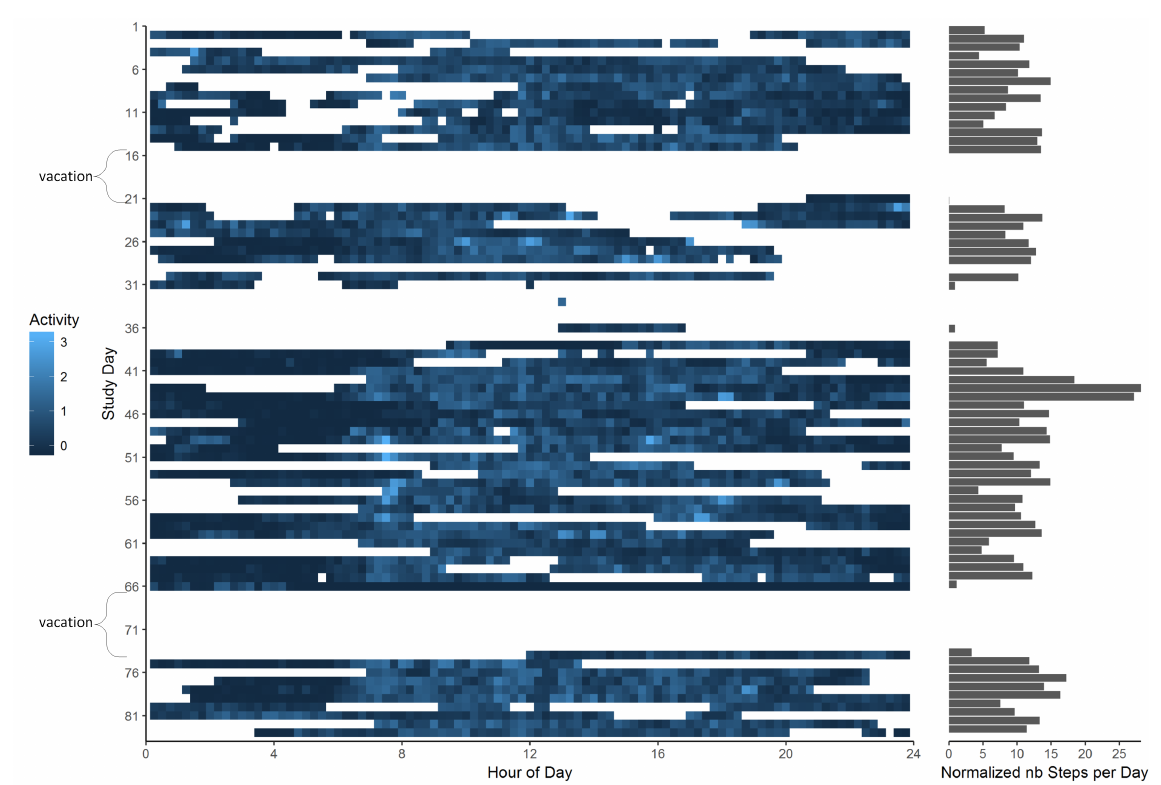
Figure 4. Activity levels ( log( mean ( activity over 15 minutes )) ) over the study period: rows represent days from 0:00 to 24:00. The right hand side presents the number of stes normalized to the number of measurement samples per